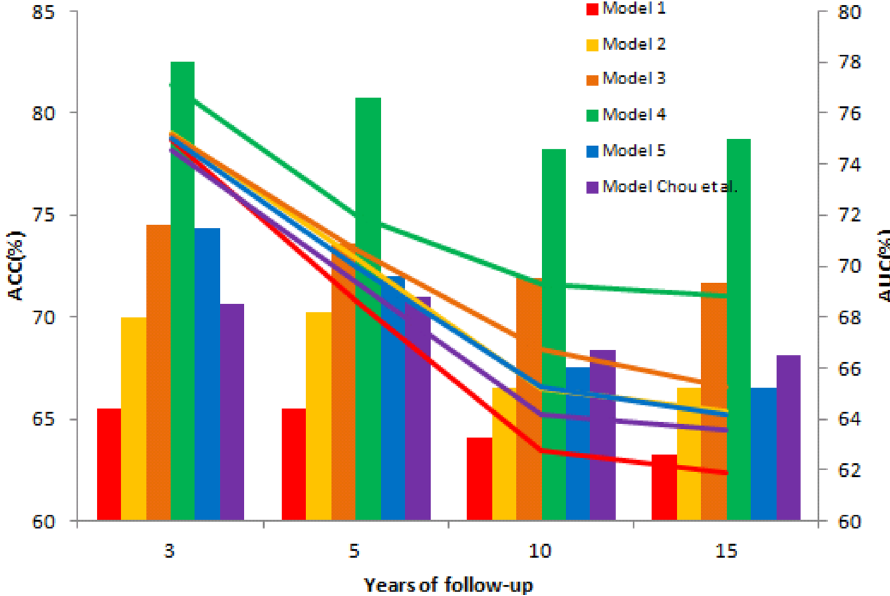
Figure 1. The ACCs (bar chart) and AUCs (histogram) of Model 1–5 and Model from Chou’s study 28 for predicting the 3, 5, 10 and 15-year RFS in